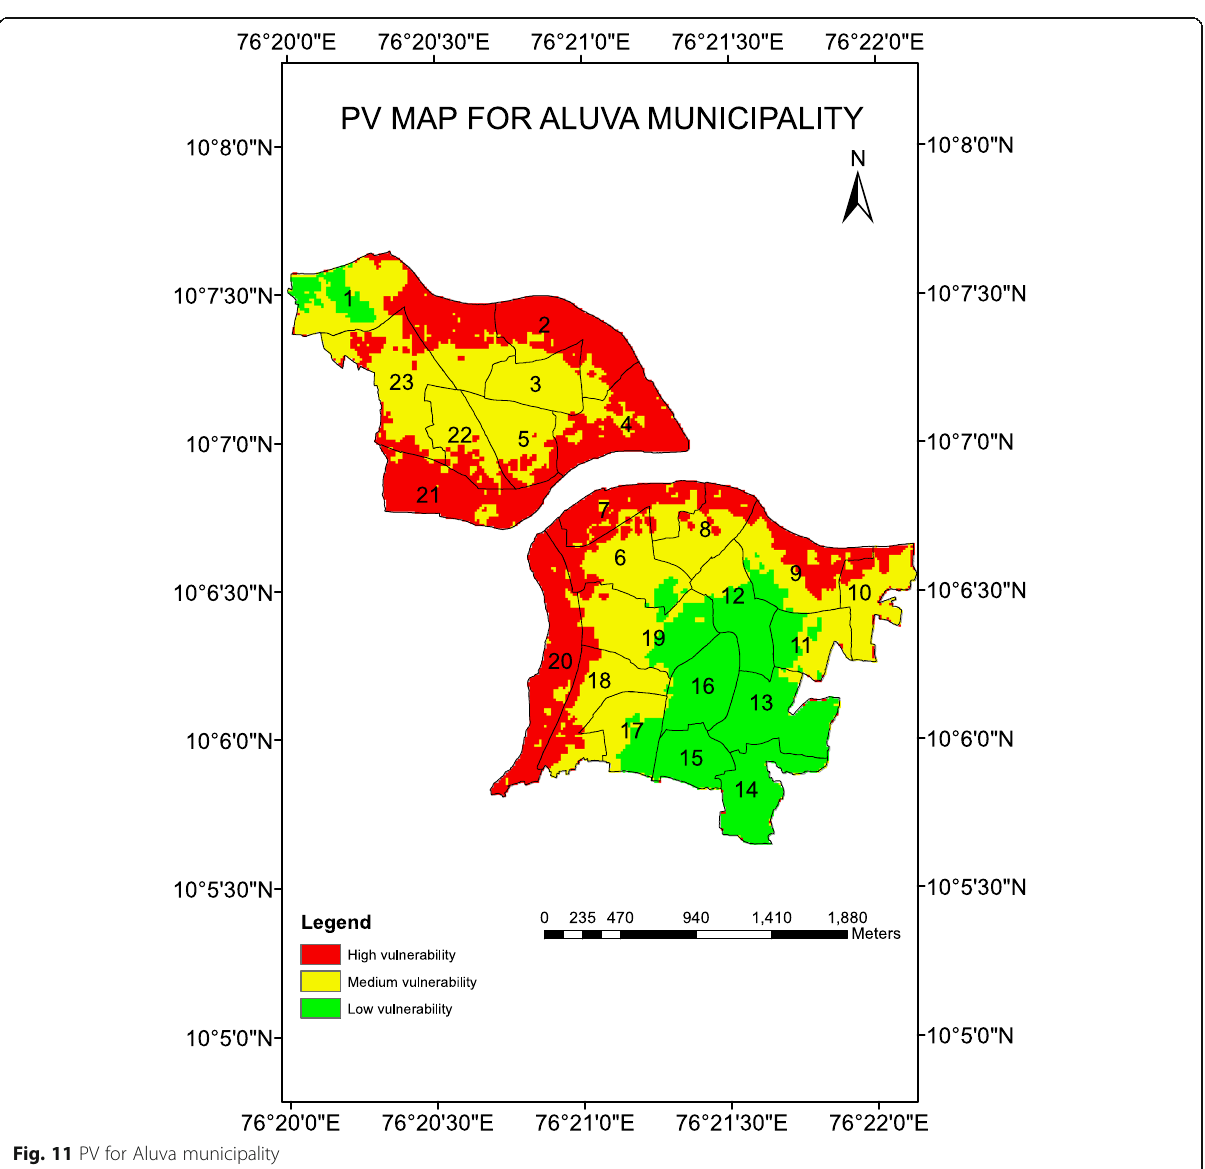
Fig. 11 PV for Aluva